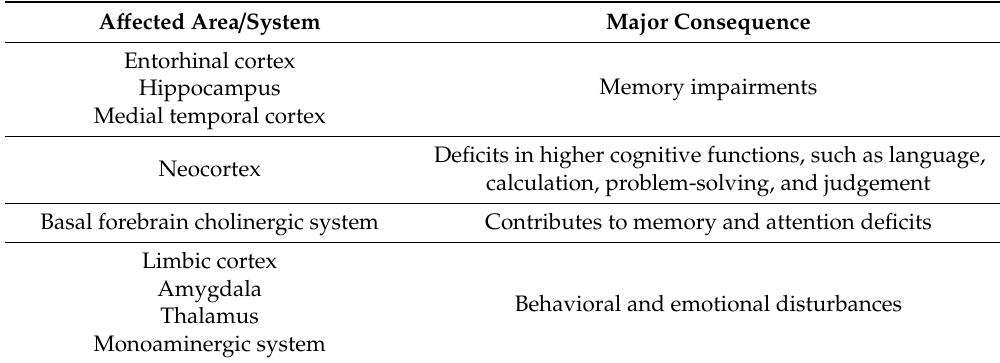
Table A1. Summary of brain areas and systems commonly a ff ected in AD patients and the major consequences according to Arnold et al. (1991), Firth et al. (2019), and Bruen et al.